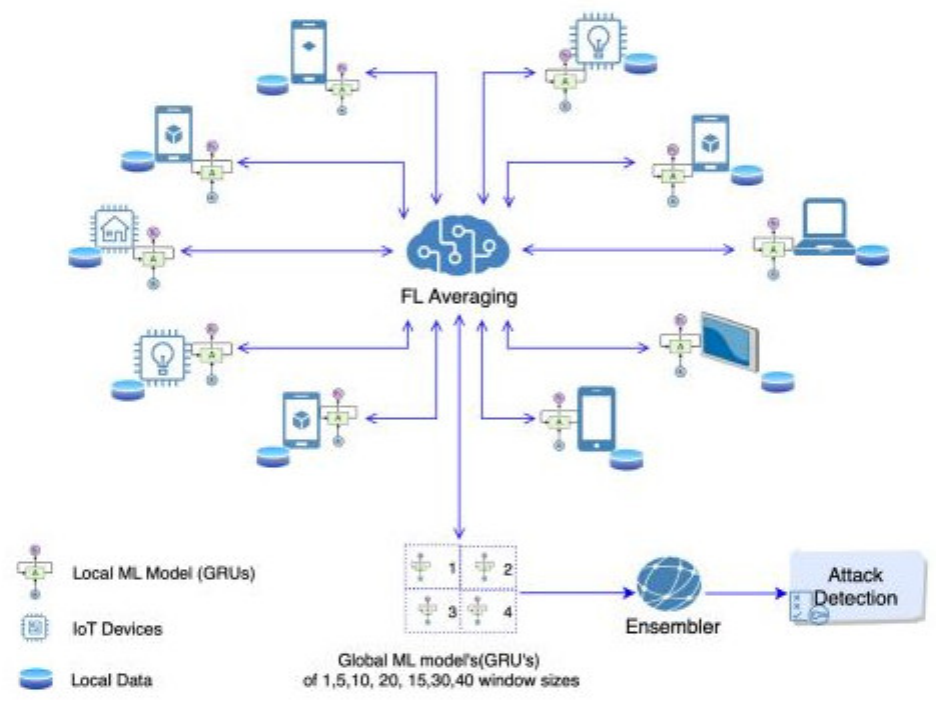
Figure 2. FL-based Attack